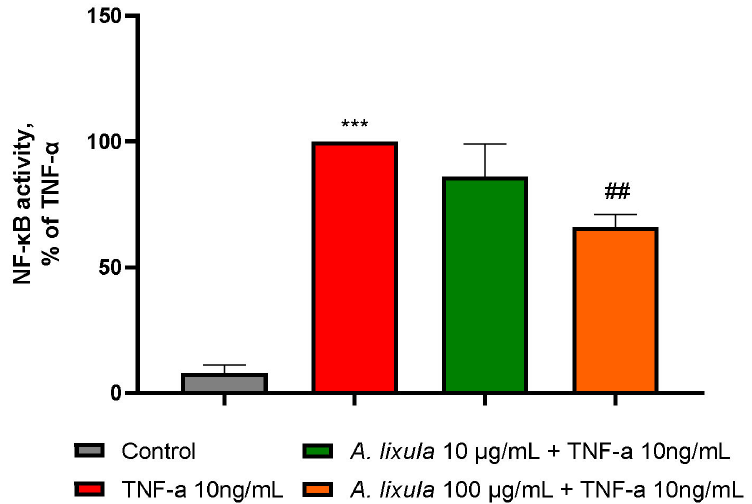
Figure 6. Effect of A. lixula extract on TNF- α -induced NF- κ B activation. HMEC-1 were treated with A. lixula extract for 4 h at the concentration indicated, and then either treated with 10 ng/mL TNF- α or left untreated for 1 h. Nuclear proteins were analyzed for NF- κ B p65 DNA-binding activity by ELISA. Data (means ± S.D., n = 3) are expressed as percent of TNF- α . *** p < 0.001 vs. basal (untreated) control; ## p < 0.01 vs. TNF- α